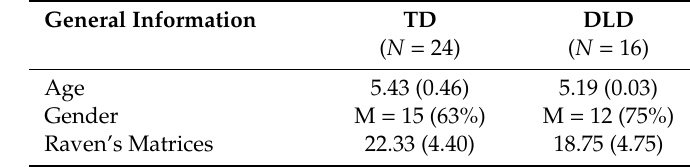
Table 1. Age, gender, and performance on a non-verbal reasoning task (i.e., Raven’s matrices) of the two groups of participants. Data are presented as means (and standard deviations, SD) for age, number of participants, and percentage for gender and raw scores (mean and SD) for Raven’s